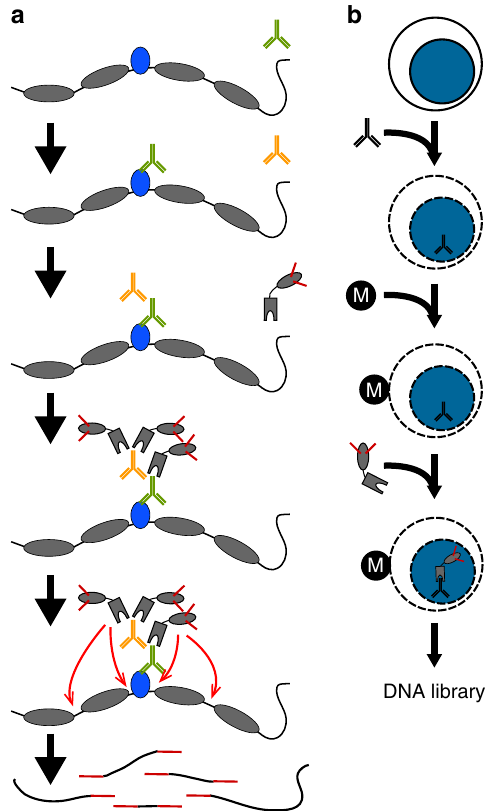
Fig. 1 In situ tethering for CUT&Tag chromatin pro fi ling. a The steps in CUT&Tag. Added antibody (green) binds to the target chromatin protein (blue) between nucleosomes (gray ovals) in the genome, and the excess is washed away. A second antibody (orange) is added and enhances tethering of pA-Tn5 transposome (gray boxes) at antibody-bound sites. After washing away excess transposome, addition of Mg ++ activates the transposome and integrates adapters (red) at chromatin protein binding sites. After DNA puri fi cation genomic fragments with adapters at both ends are enriched by PCR. b CUT&Tag is performed on a solid support. Un fi xed cells or nuclei (blue) are permeabilized and mixed with antibody to a target chromatin protein. After addition and binding of cells to Concanavilin A- coated magnetic beads (M), all further steps are performed in the